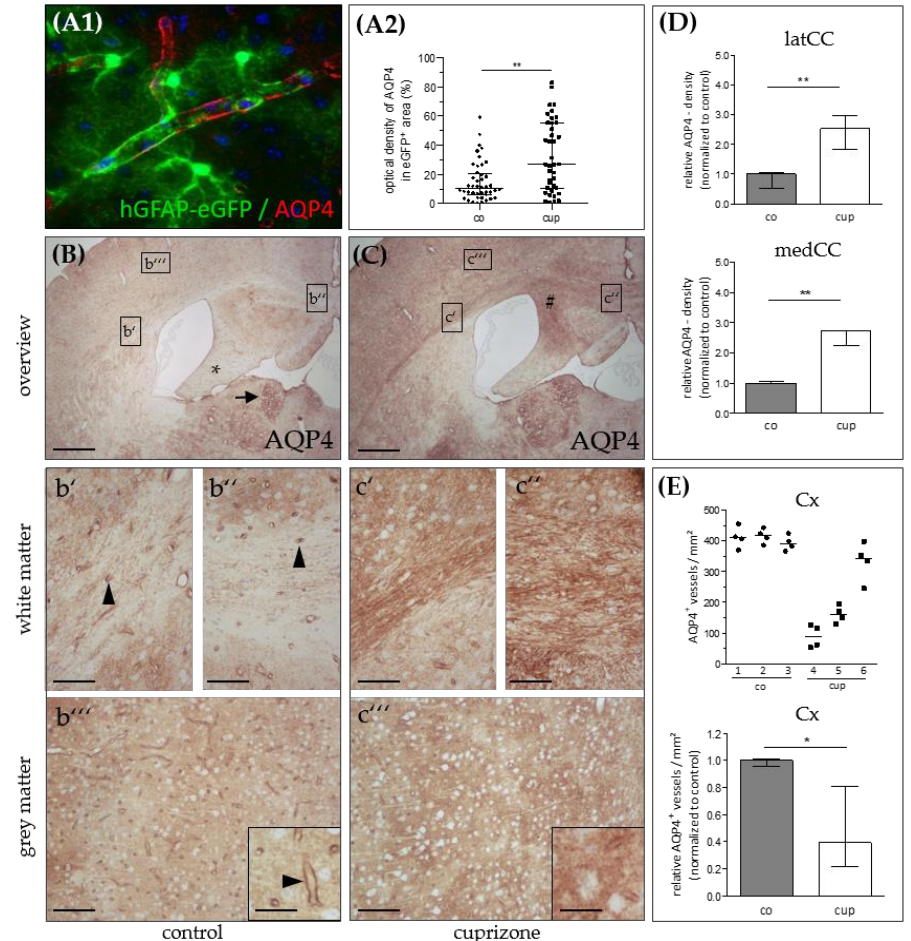
Figure 1. Aquaporin-4 (AQP4) expression in the cuprizone model. ( A1 ) Representative image demonstrating expression of AQP4 (red) in eGFP-expressing astrocytes (green). ( A2 ) Relative anti-AQP4 staining intensities (control and 5 weeks cuprizone) within the area covered by single eGFP-expressing astrocytes. Data are shown as median + IQR; tested via Mann-Whitney U; co n = 44, cup n = 39. ( B ) AQP4 expression in control (co) animals. The lateral corpus callosum ( b’ ), medial corpus callosum ( b” ), and grey matter cortex ( b”’ ) are shown in higher magnification. The star highlights the hippocampal fimbria region; the arrow highlights the habenula; the arrowheads highlight AQP4-immunoreactive capillaries. ( C ) AQP4 expression in animals intoxicated with cuprizone for 5 weeks. The lateral corpus callosum ( c’ ), medial corpus callosum ( c” ), and grey matter cortex ( c”’ ) are shown in higher magnification. The hash sign highlights the hippocampal alveus. Scales: ( B , C ) 180 µ m, ( b’ – b”’ , c’ – c”’ ) 90 µ m, inserts 30 µ m. ( D ) Semi-automatic optical density analyses of anti-AQP4 immunoreactivity in the lateral (latCC) and medial (medCC) corpus callosum in control mice and after 5 weeks cuprizone intoxication. ( E ) Semi-automatic quantification of anti-AQP4-positive microvessel densities in the cortex (Cx) per mm 2 in control mice and after 5 weeks cuprizone intoxication (top: absolute values, bottom: relative values). Data are shown as median + IQR; tested via repeated measures ANOVA; n = 3 per group; * = p < 0.05, ** = p < 0.01.